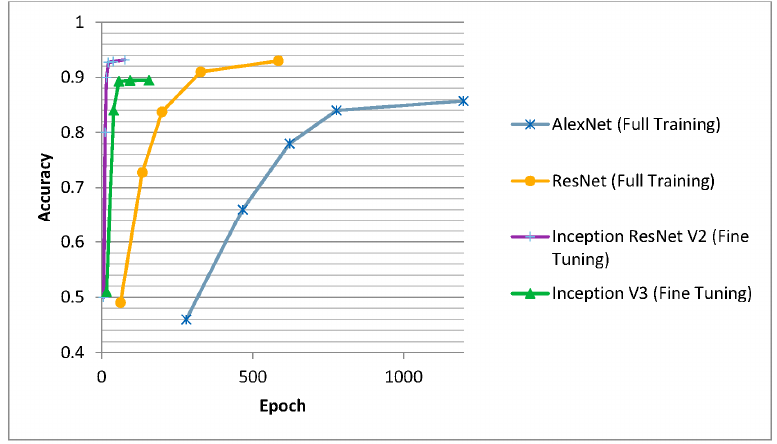
Figure 9. Comparison of the epochs needed in each case to reach convergence. Table 7. Confusion matrix obtained using a ResNet network (full-training) and the validation dataset (the rows correspond to the actual values and the columns to the predicted values). Bell Dome Column Tower (Inner) Category Altar Apse Bell Tower Column